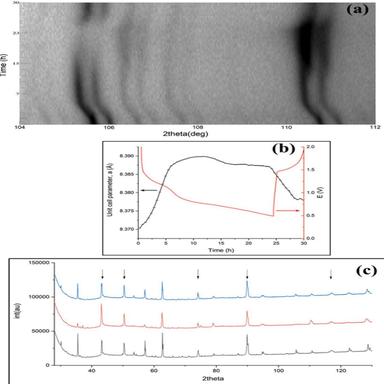
(a) 2D representation of a part of the diffraction patterns during the first discharge/charge cycle of LZTNO-05. (b) Unit cell parameter (a-axis) during the first discharge/charge cycle of LZTNO-05 and the current during discharge was 50 μA and the voltage is shown in inset. (c) XRD patterns of LZTNO-05 at different charge/ discharge state in the initial, charged and final state. The arrows indicate contributing reflections from the copper grid in the in-situ cell.